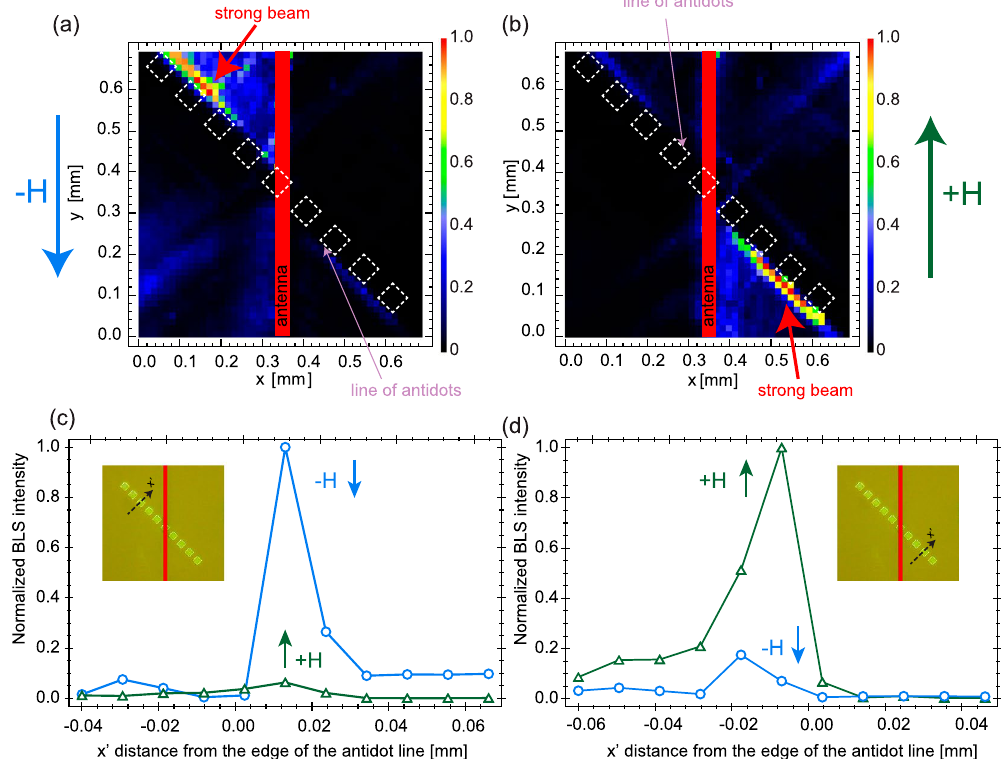
Figure 3. Experimental demonstration of the spin wave beam formation combined with a spin wave switching. Two-dimensional color map of the SW amplitude based on the acquired BLS data. A SW beam is formed along the antidot line, and switched by 180° on reversal of the magnetic field direction from − H ( a ) to + H ( b ). The SWs are generated by a microwave antenna (red vertical bar) at a frequency of 4.98 GHz at H = 980 Oe. ( c , d ) Spatial distribution of normalized BLS intensity along a line perpendicular to the row of antidots (black-dashed line in the insets) on the left ( c ) and right ( d ) of the antenna for − H (blue circles) and + H (green triangles). The zero distance corresponds to the edge of the